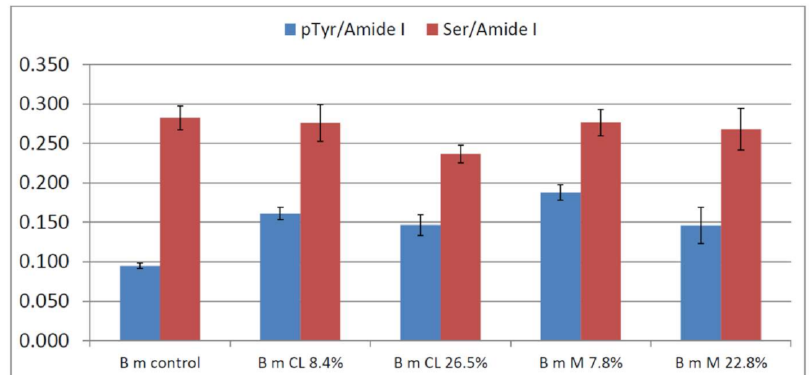
Figure 4. Values of the I pTyr /I Amide I and I Ser /I Amide I intensity ratios (average ± standard deviation) obtained from the Raman spectra of B. mori silk fibroin fabrics under study.